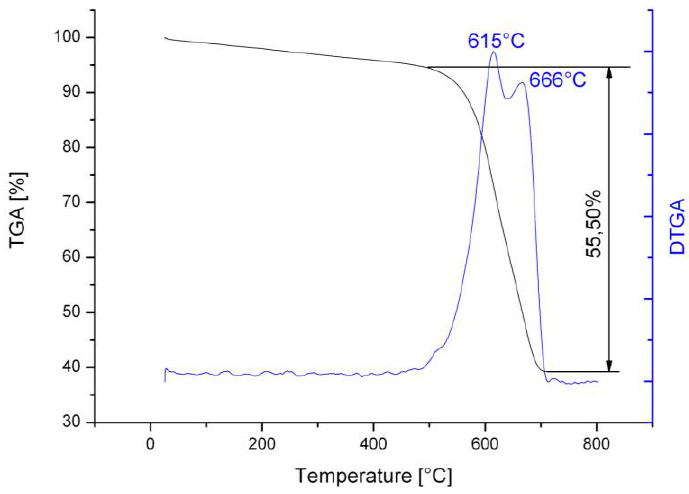
Figure 5. TGA and DTGA diagrams of the nanostructured silica fume with two mass loss